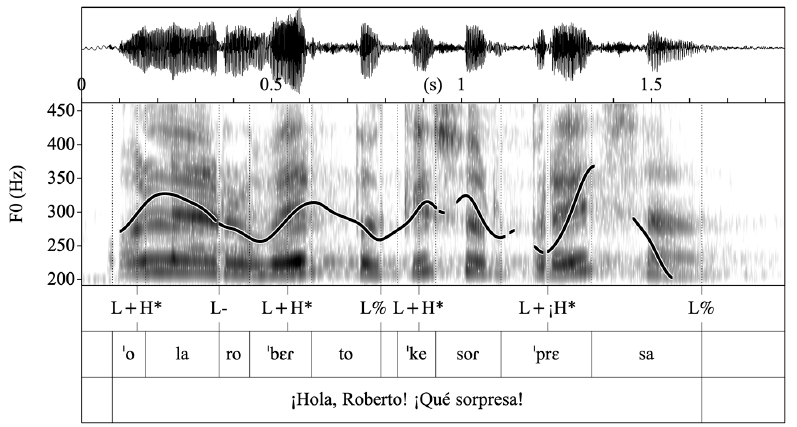
Figure 20. Waveform, spectrogram and F0 trace of the what -exclamative ¡Hola, Roberto! ¡Qué sorpresa! in L2 Spanish (F16, level C2) produced with the target-like L+¡H* L% pattern. Not all sentences showed a target-like form. The L2 data yielded several patterns that were completely absent from the Italian or Spanish control data. The following two pairs of non-neutral statements represent what I would call a typical Czech intonation pattern.